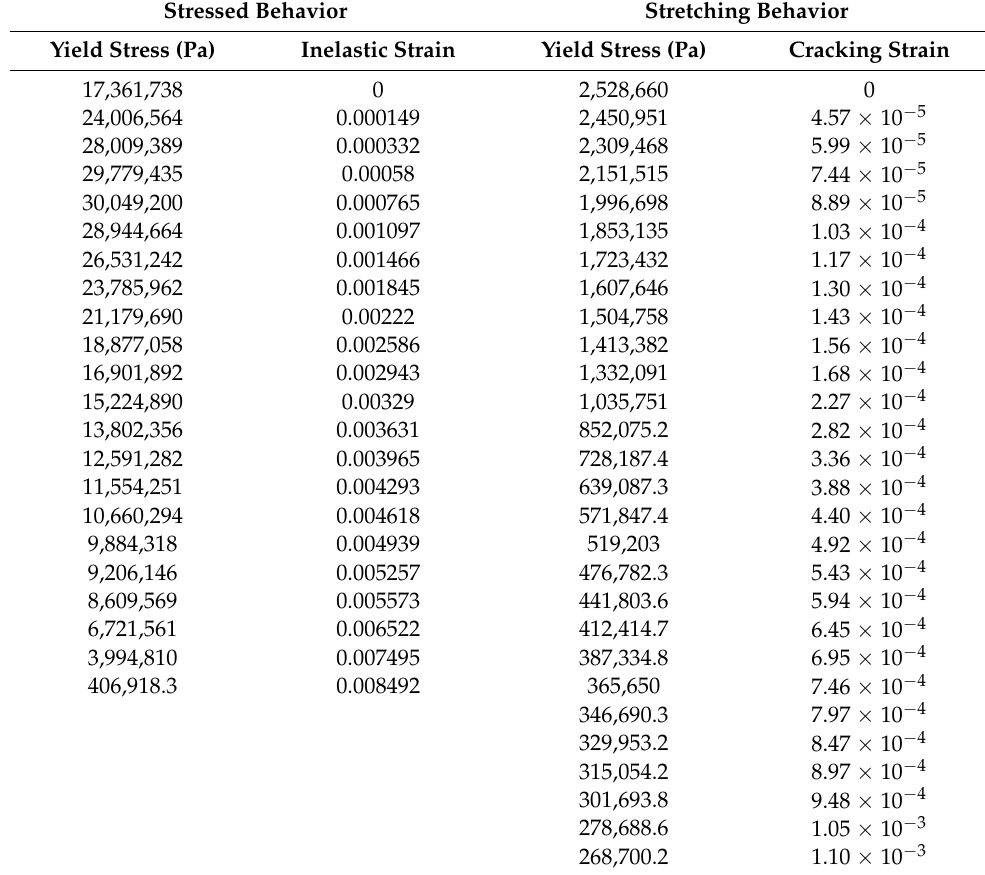
Table 2. Tensile and compressive parameters of the concrete damage-plastic model.